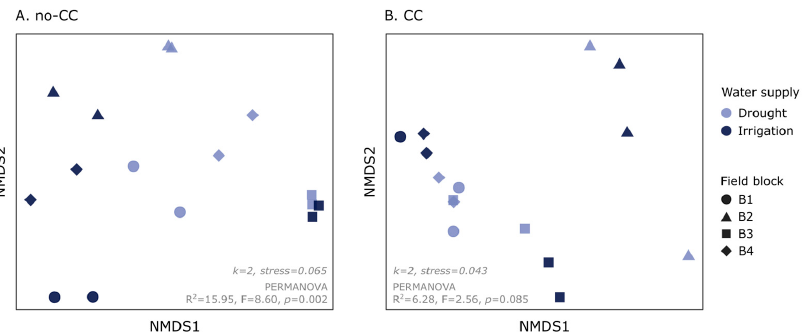
Figure 3. Nonmetric multidimensional scaling (NMDS) showing changes in soil arbuscular mycor- rhizal fungi (AMF) community composition (weighted UniFrac) in response to water supply (drought, irrigation). The results are shown separately for each cover crop treatment: no cover crop (no-CC) ( A ) and 4-species cover crop (CC) ( B ). Each plot also shows the NMDS dimensions (k) and stress values, as well as the water supply effects according to PERMANOVA (R 2 = % variance ex- plained, F-value, p -value). The full PERMANOVA results can be found in Table S2.